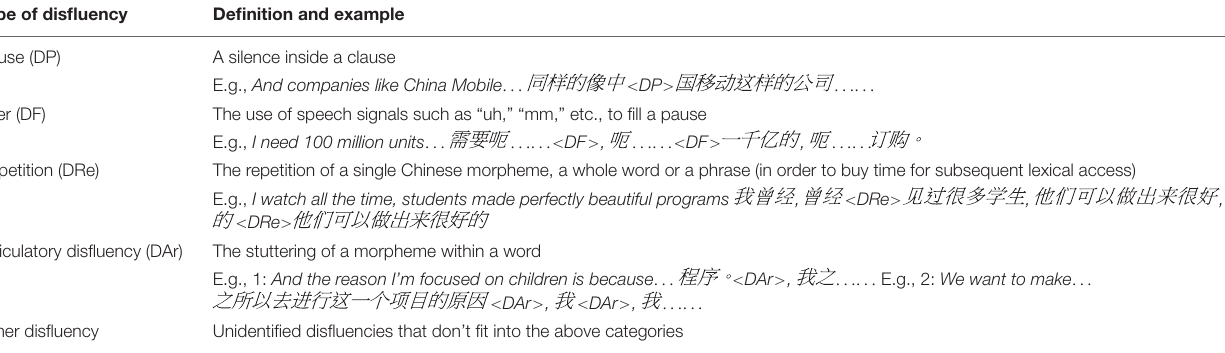
TABLE 1 | Classification of disfluencies in interpreting, with